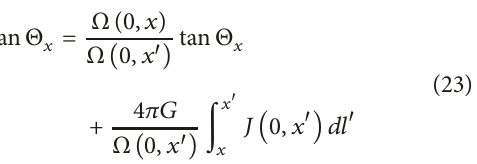
𝑥 ∈ 𝑆1 , 𝑥 耠 ∈ 𝑆2 , 푖 푖